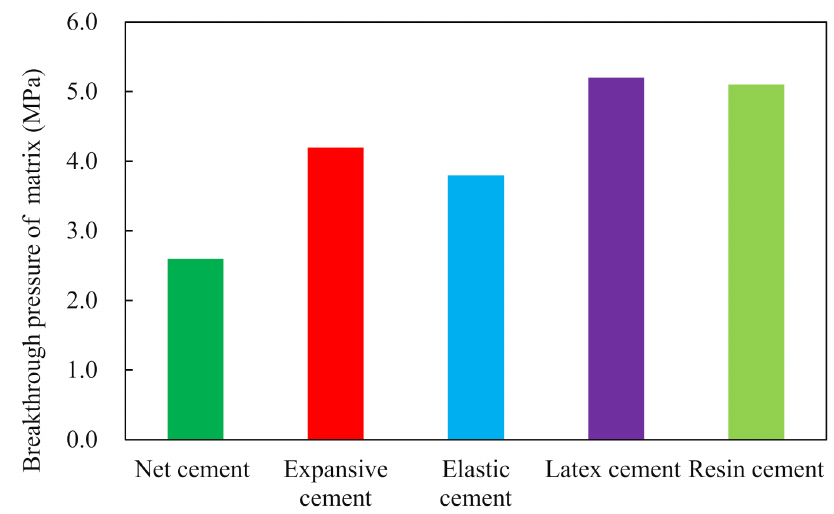
Figure 6. Impact of cement slurries on the breakthrough pressure of matrix.